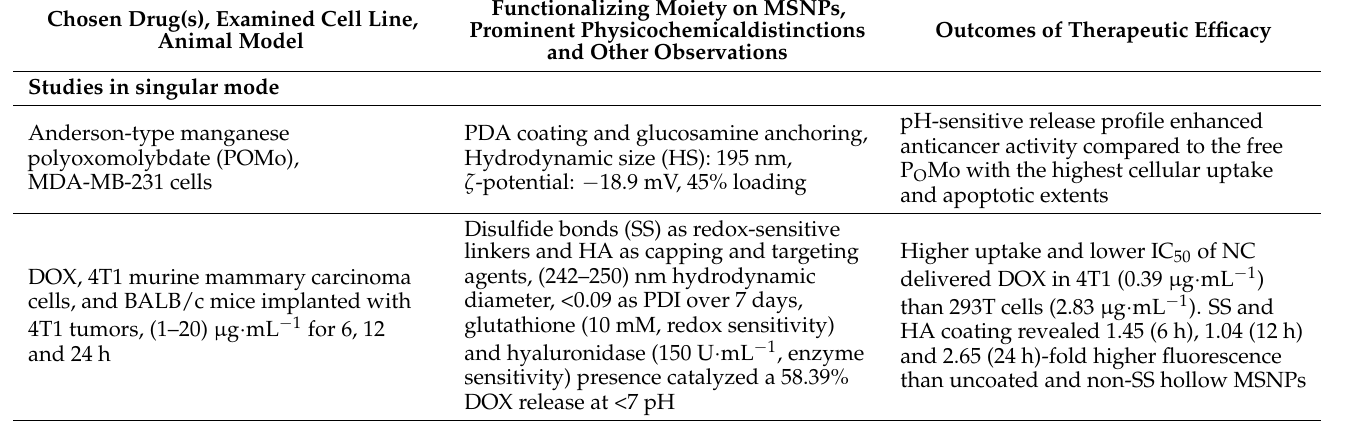
Table 2. Summary of few research attempts using mesoporous silica nanoparticles as delivery vehicles for trafficking chemotherapeutic drugs to bresat cancer cells. The in vivo conduct of these investigations infers a readiness for their furtherance to clinical or terminally ill patients